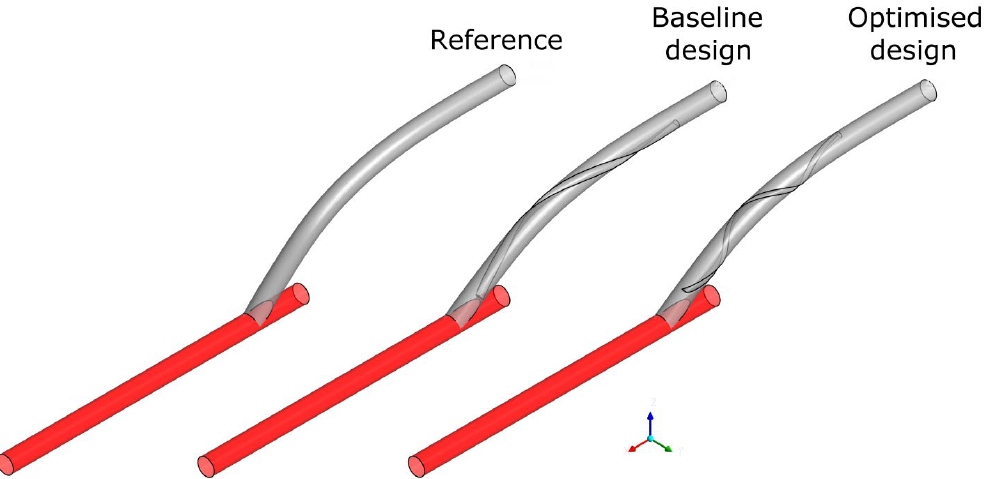
Figure 3. Comparison of the configuration of the reference, the baseline ridge design, and the optimised results of the current work.